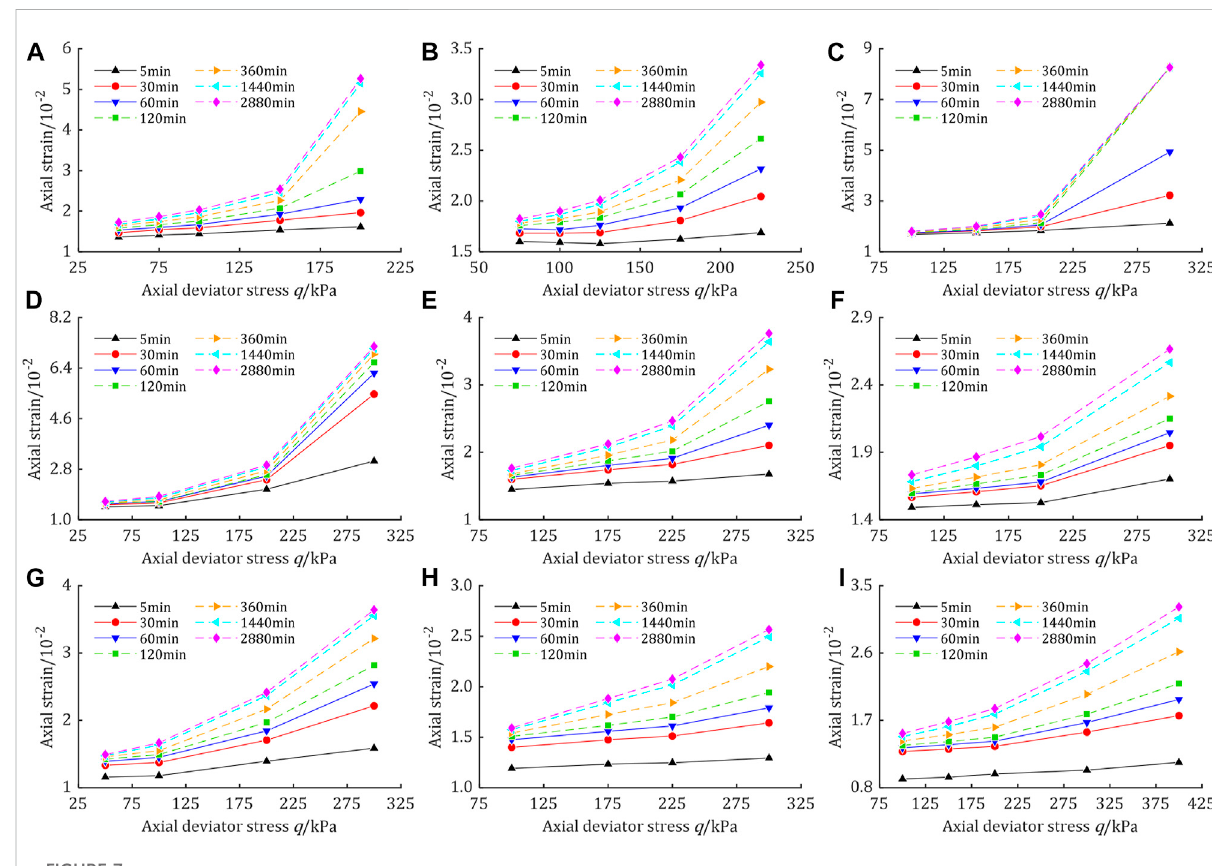
FIGURE 7 Isochronous stress-strain curves. (A) σ 3-ua=50kPa, s=50kPa; (B) σ 3-ua=50kPa, s=100kPa; (C) σ 3-ua=50kPa, s=200kPa; (D) σ 3-ua=100kPa,